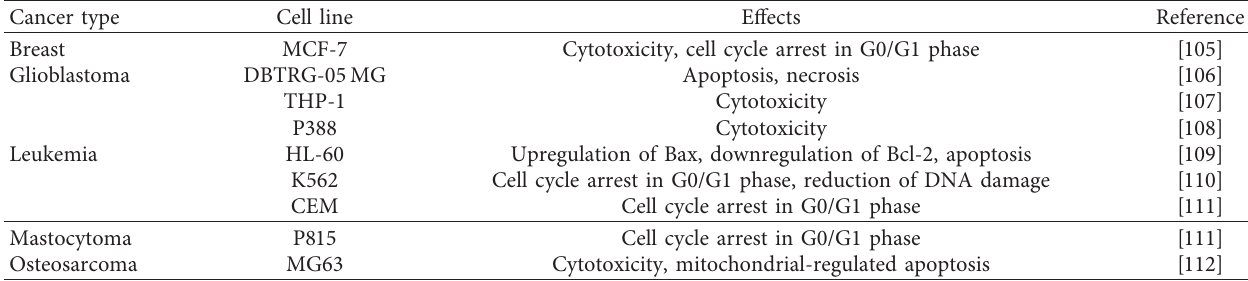
Table 4: The anticancer effects of thymol on different cell lines.